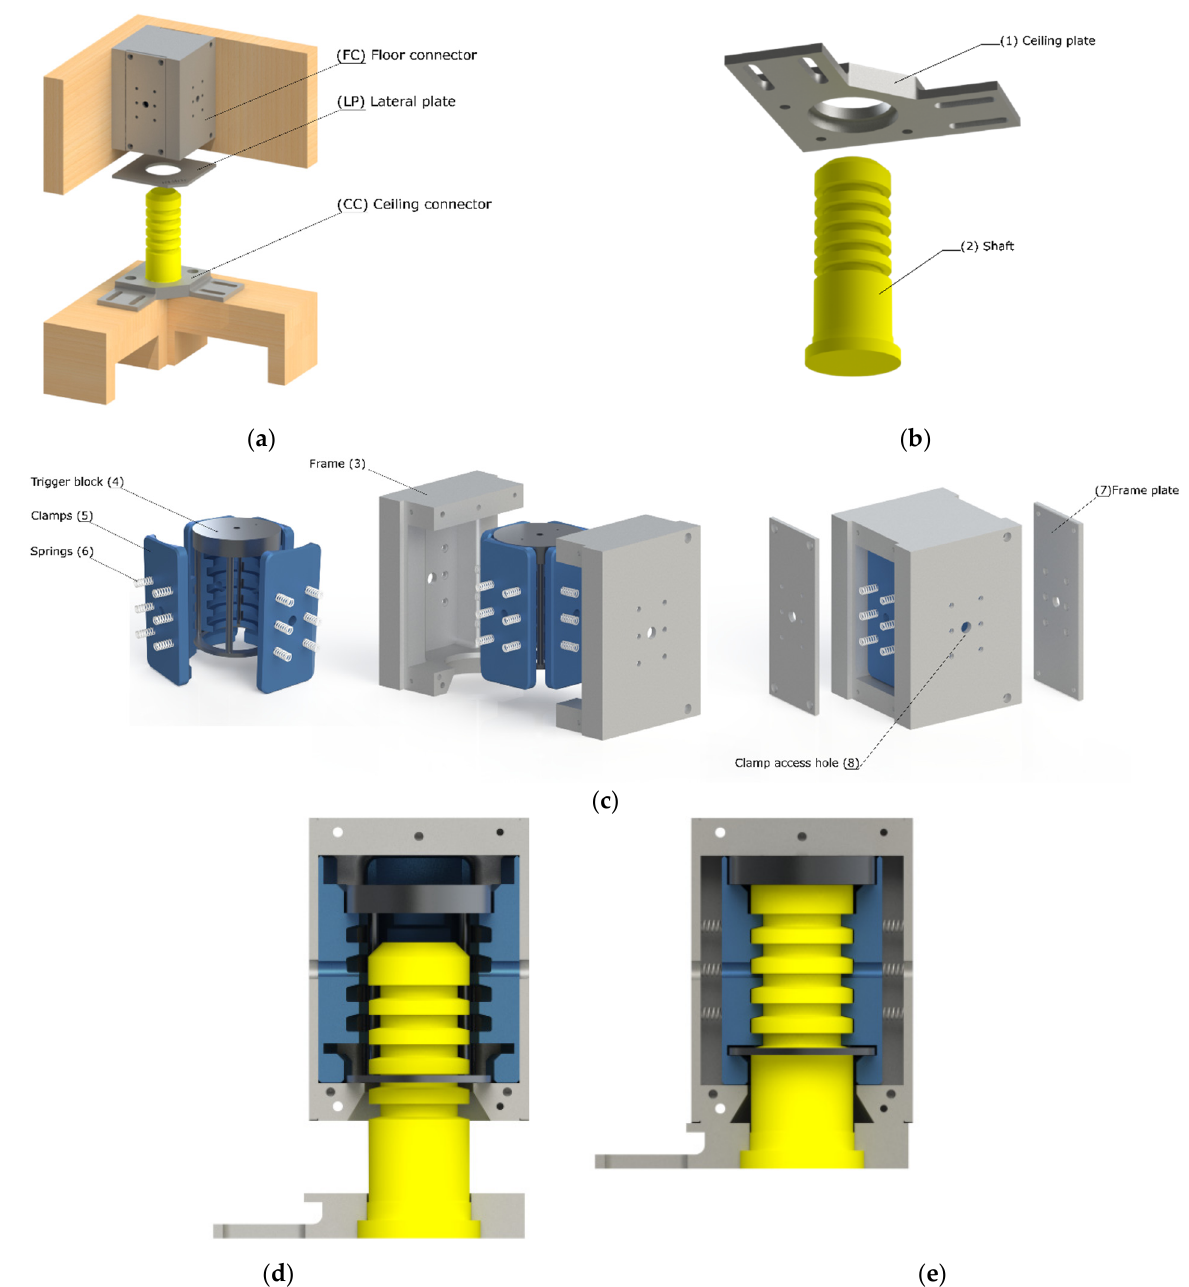
Figure 3. ( a ) 3D model of the connector in a wood module, ( b ) Exploded view of a 3D model of the ceiling connector (CC), ( c ) Exploded view of a 3D model of the floor connector (FC), ( d ) Section view of a 3D model of the connector prior to connection, ( e ) Section view of a 3D model of the connector after connection.